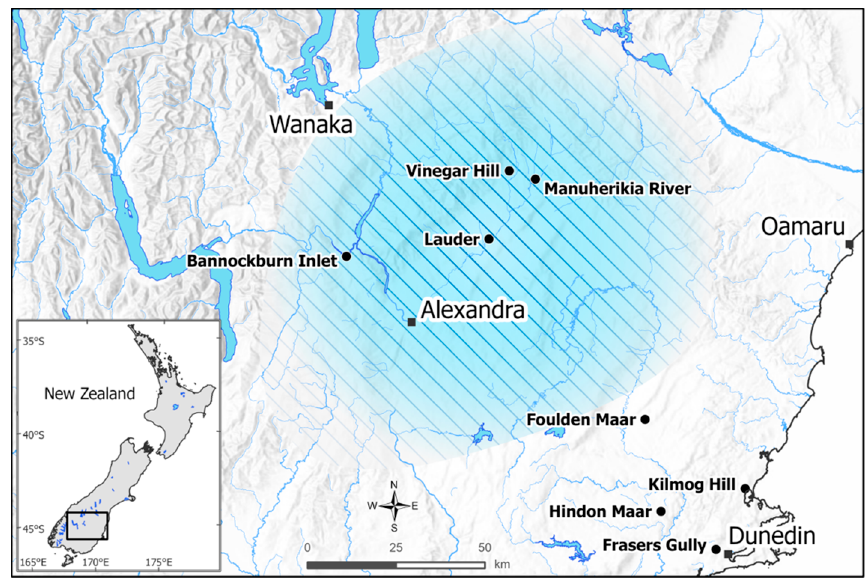
Figure 1. Locality map showing sites for Galaxias fossils in Otago, New Zealand. Shaded area shows approximate extent of Lake Manuherikia in the early Miocene.